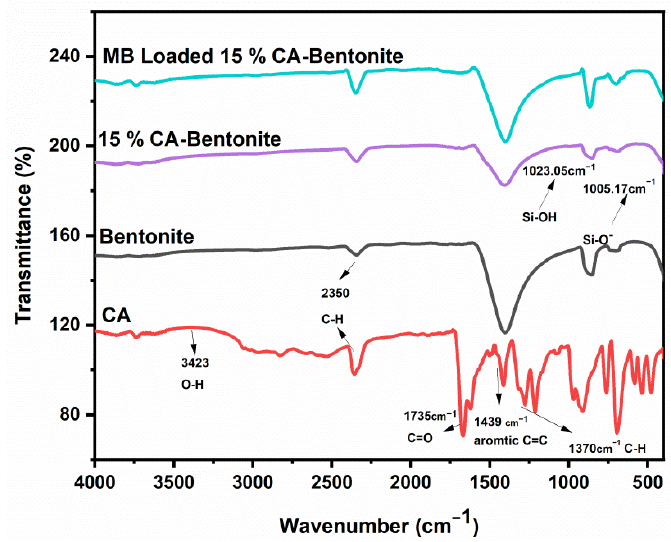
Figure 1. FTIR spectrum of raw and cinnamic acid activated bentonite clay.